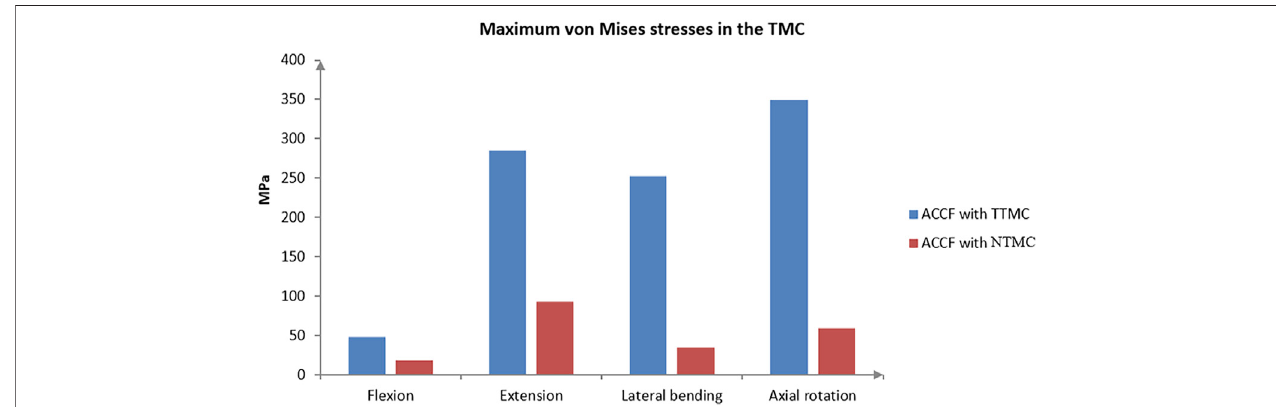
FIGURE 7 | Comparisons of the maximum von Mises stresses in the TMC between TTMC and NTMC models.